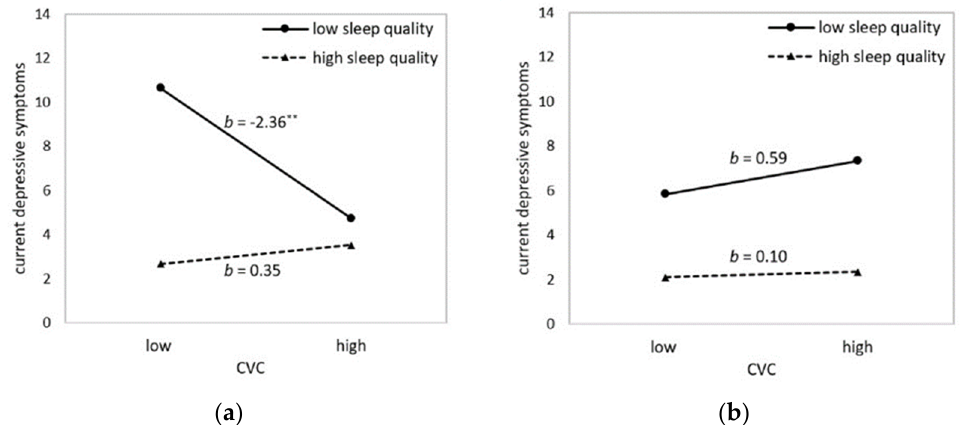
Figure 1. Illustration of the interaction between sleep quality (PSQI) and CVC (HF-HRV) in predicting current depressive symptoms (BDI-II’1): ( a ) in women and ( b ) in men. High sleep quality corresponds to low PSQI scores. Values show estimates at means ±1 SD. Asterisks denote slopes that are significantly different from zero. ** p ≤ 0.01.